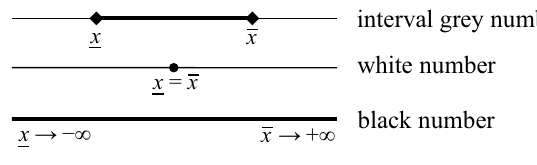
Fig. 1. White, black and interval grey